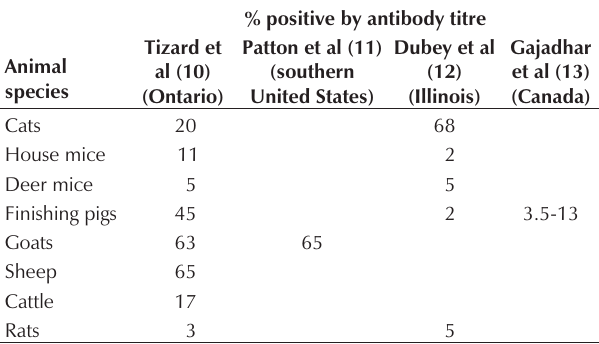
Prevalence of serum antibodies to Toxoplasma gondii Parasite isolations from human fecal sample submissions for